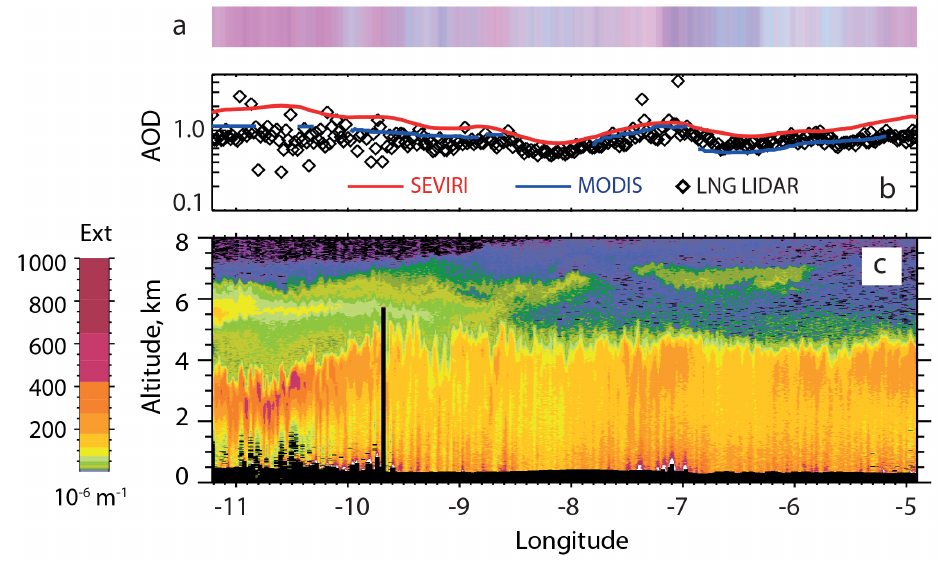
Figure 10. Aircraft and satellite observations along the track of the outbound Falcon flight F23 on the 21 June (13:52–14:45UT), across northern Mauritania and ending in northern Mali. Lower panel: lidar vertical extinction coefficient cross1953 section (at 532nm); middle panel: co-located SEVIRI, MODIS, and lidar (LNG) AOD retrievals along the Falcon flight track; upper panel: the along-track SEVIRI RGB “desert-dust”